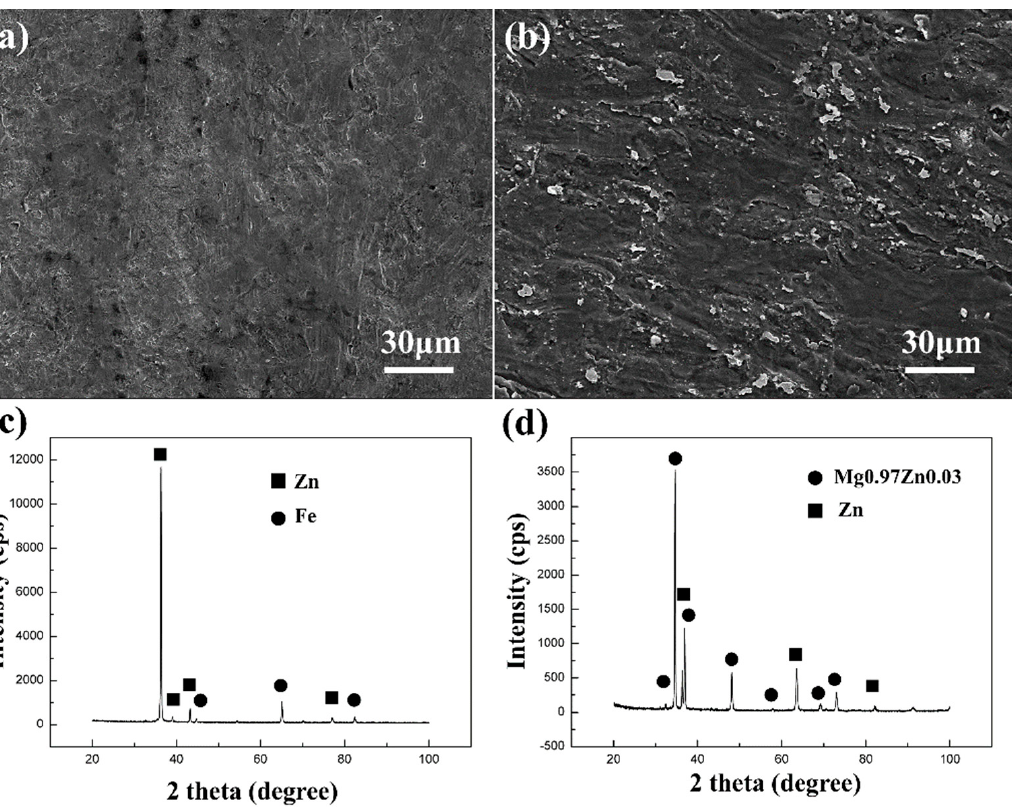
Figure 5. ( a , b ) Fracture surfaces of the steel side and of the AZ31 side. ( c , d ) XRD spectra of the steel side and of the AZ31 side (Zn: ICCD card M010870713; Fe: ICCD card N010851410; Mg0.97Zn0.03: ICCD card N030654596;).